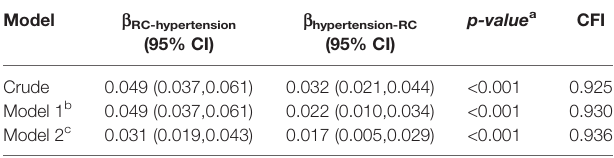
TABLE 5 | Crude and adjusted cross-lagged standard regression coef fi cient of RC and blood pressure levels.